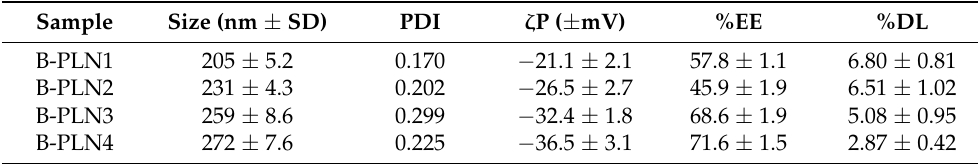
Table 1. Physicochemical characterisation of nanoparticles